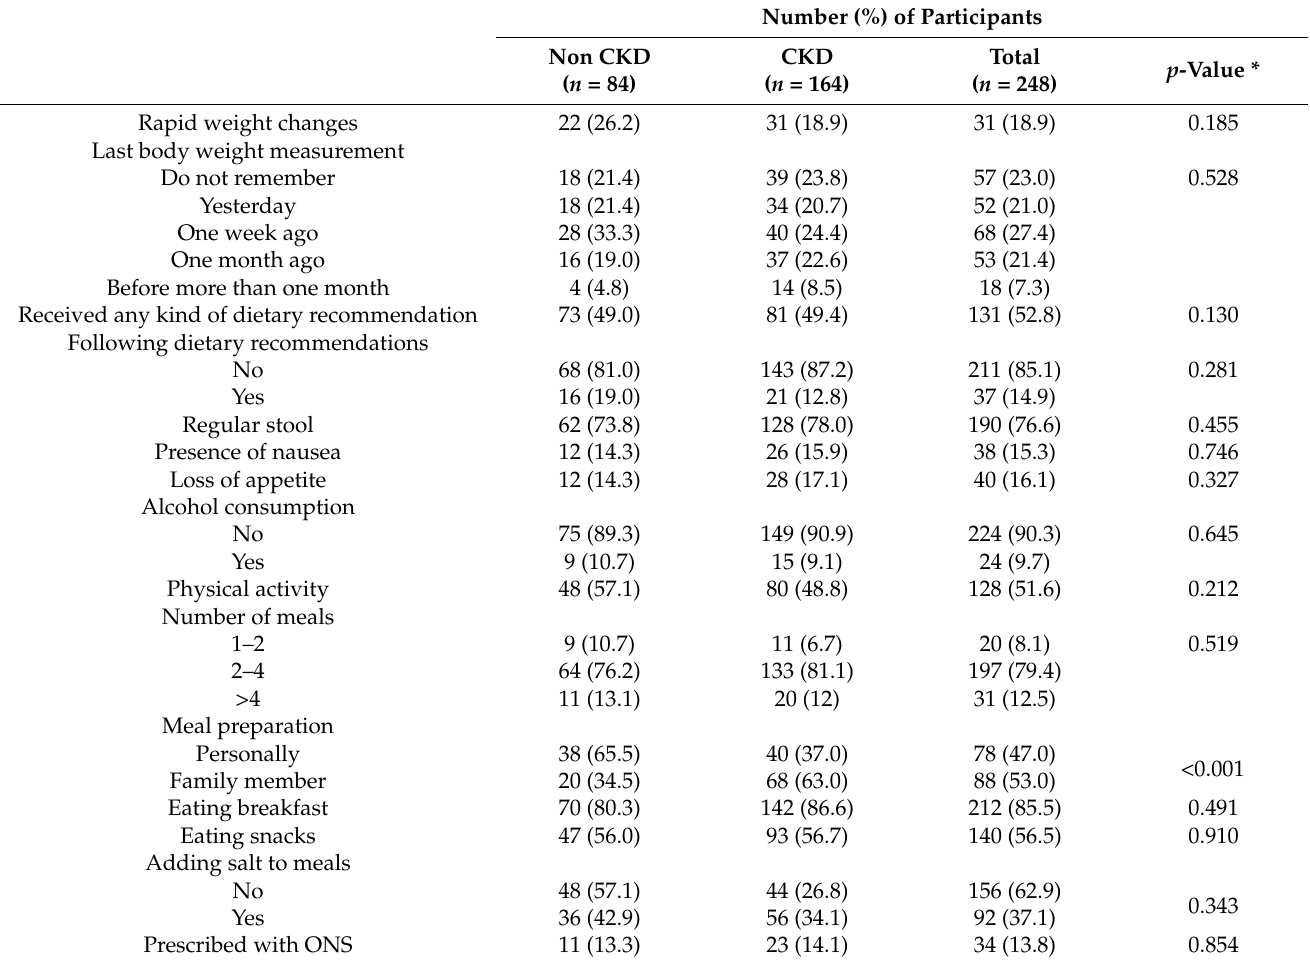
Figure 3. Adherence to the MeDi and its components regarding the presence of CKD. Abbreviations: CKD, participants with chronic kidney disease; non CKD, participants without chronic kidney disease; MDSS, Mediterranean Diet Serving Score p -values were obtained with chi-square test ( p < 0.05). When adjusted for age, gender, BMI, and eGFR statistically significant associations Table 3. Lifestyle questionnaire and differences regarding the presence of CKD in all study between blood pressure parameters, body composition, and anthropometric parameters